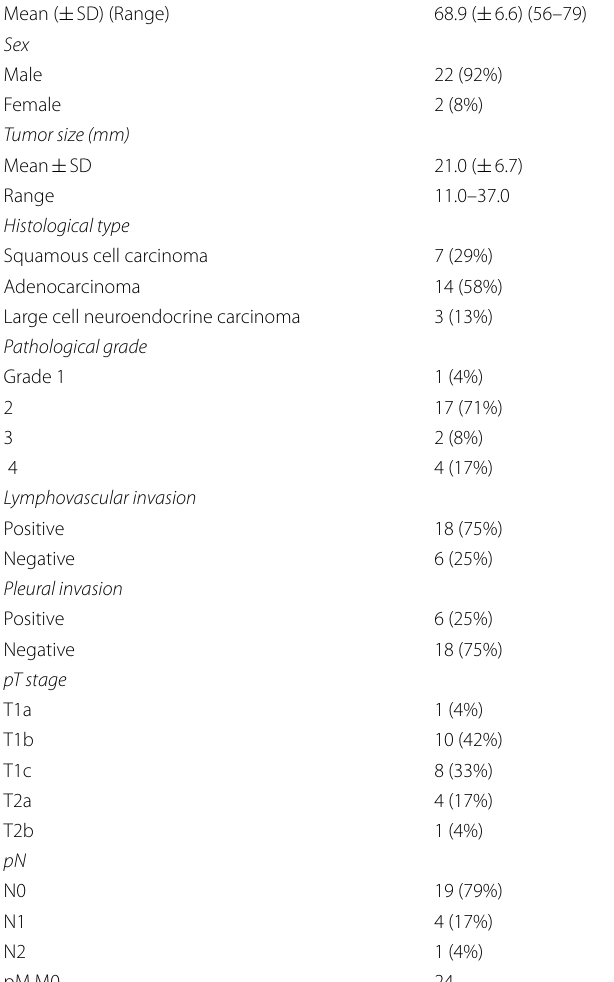
Table 3 The iodine concentration versus FVF of pleural invasion (PI) and lymphovascular invasion (LVI) of lung cancer patients